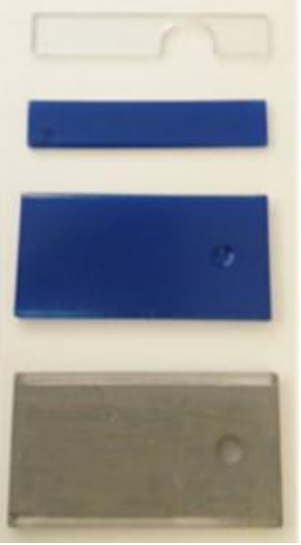
Removable Trap Pieces from the Two-Trap-Box